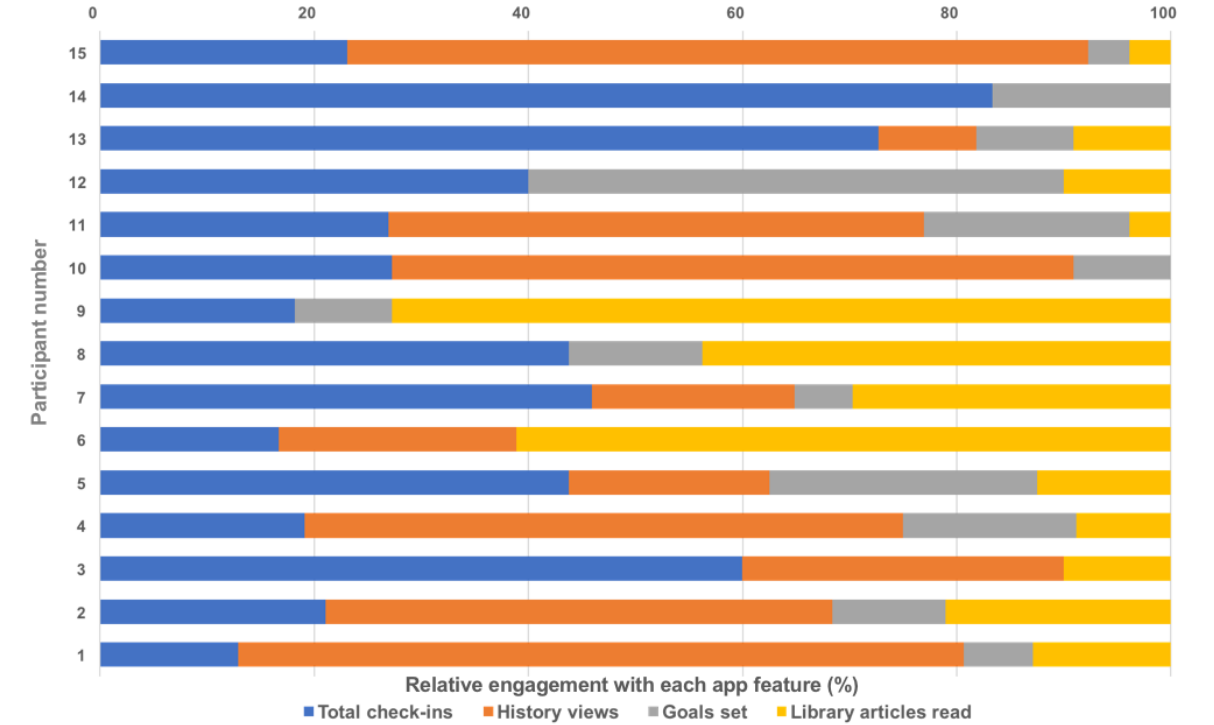
Figure 3. Individual-level data are shown for participants 1 to 15 (vertical axis). Relative user engagement (horizontal axis, proportional frequencies, and ranges for each domain) is presented across 4 key domains: (1) total (full) check-ins (blue), range 2-17; (2) history views (bright orange), range 0-38; (3) goals set (gray), 0-11; and (4) library articles accessed (light orange), range 0-11. Note that it is the variable relative engagement of each individual with the features of the